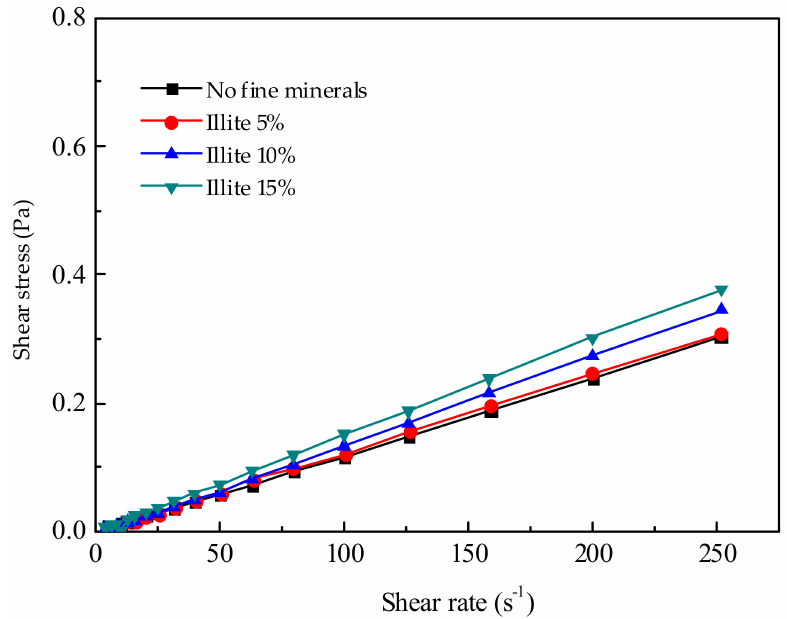
Figure 6. E ff ect of di ff erent illite additions on pulp rheology.